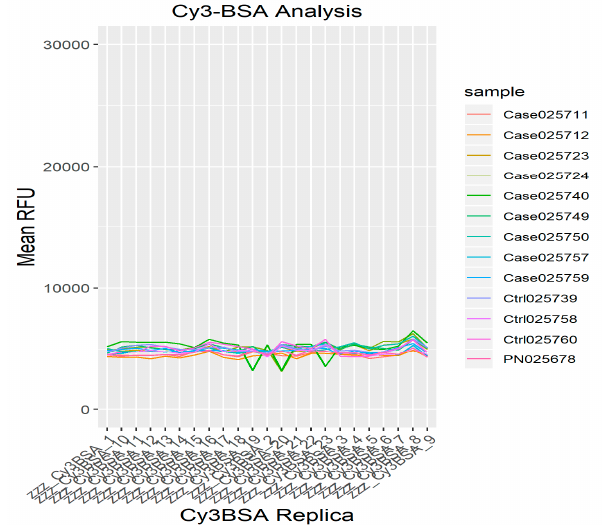
Figure 7. The RFU mean CV% for all Cy3-BSA replicates across all samples was 8.07%; was below the cut-off points which was 15%. Line plot of controls Cy3-BSA post-normalization clearly showed common intensities of Cy3BSA controls across all samples (samples are represented in different colors).